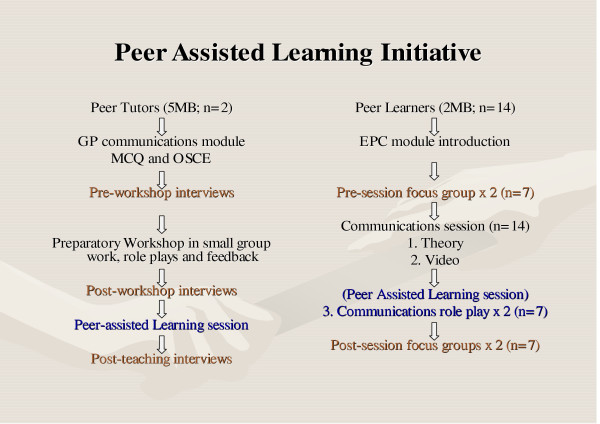
Peer Assisted Learning Initiative.